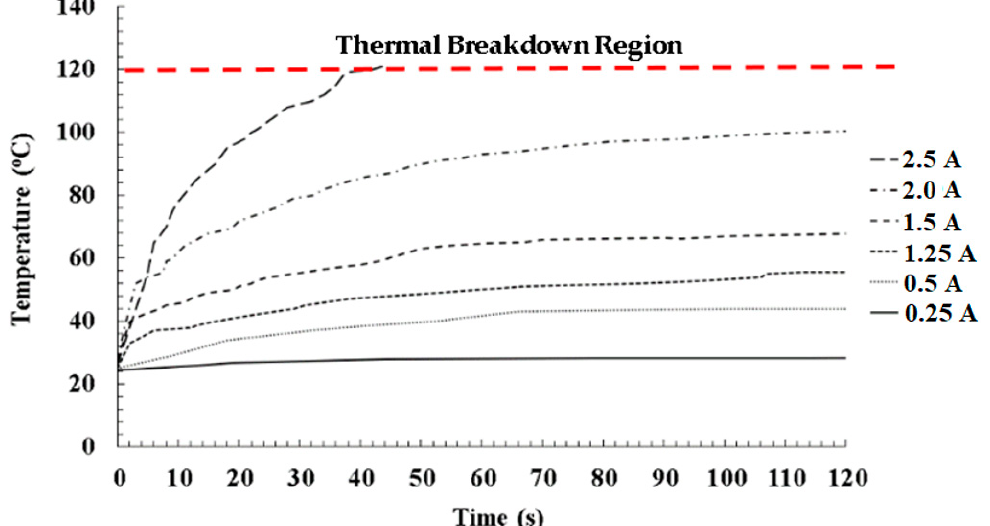
Figure 9. Temperature vs. time profile of the electrodes at various current settings. The dashed line represents the thermal breakdown region for the copper electrodes.